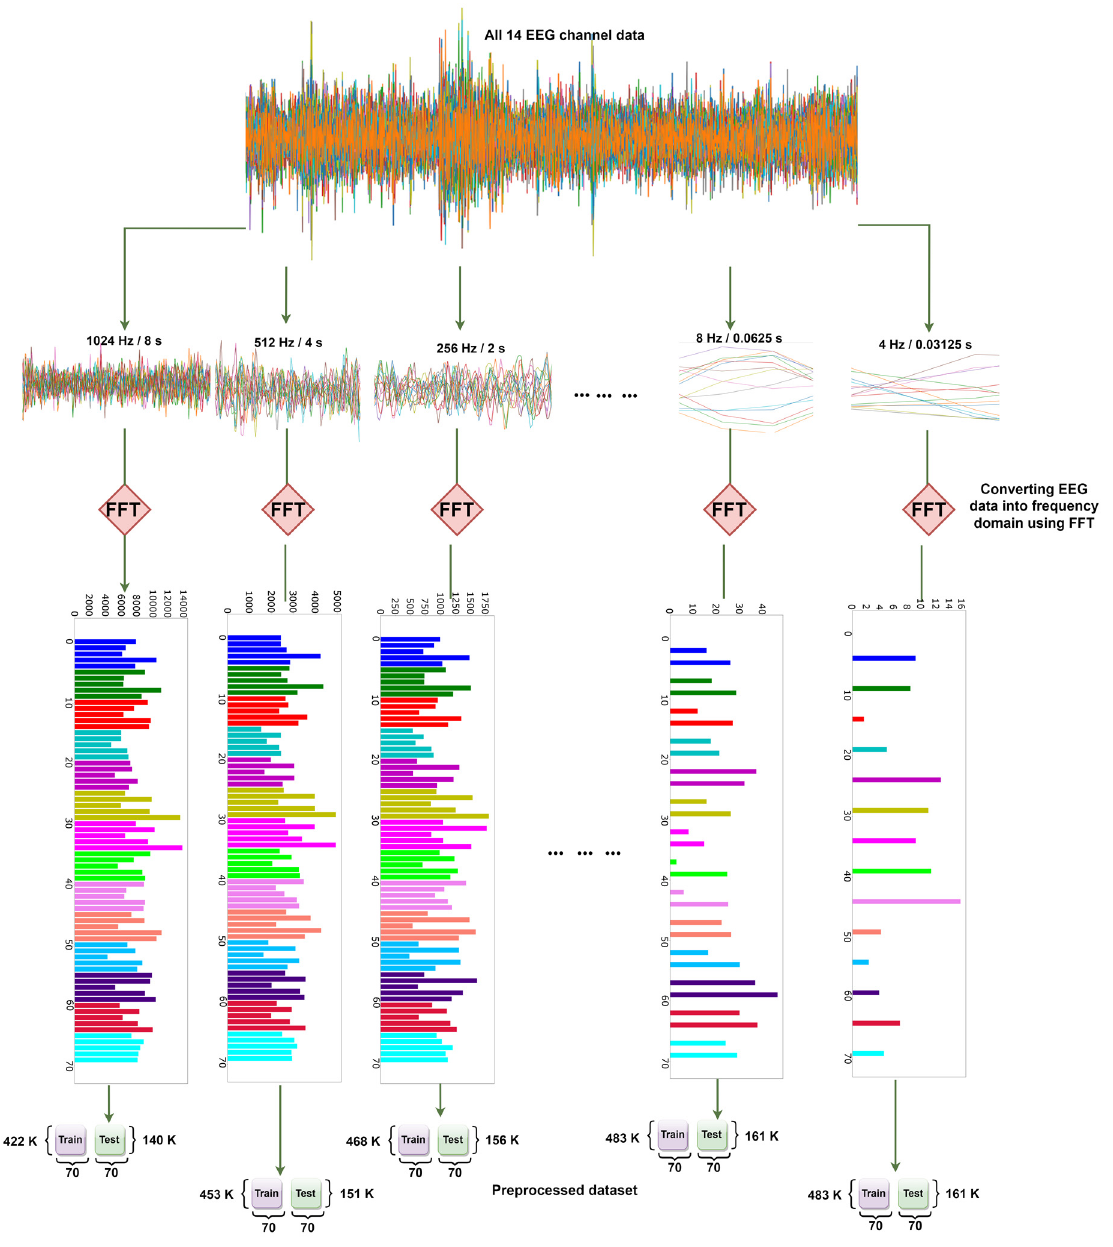
Figure 12. Generating preprocessed data with various window sizes/time slices using